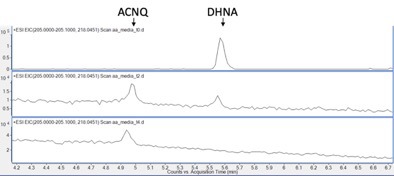
DHNA conversion to ACNQ in minimal media with amino acids as the only nitrogen source.No DHNA was observed after 6 hr of incubation.